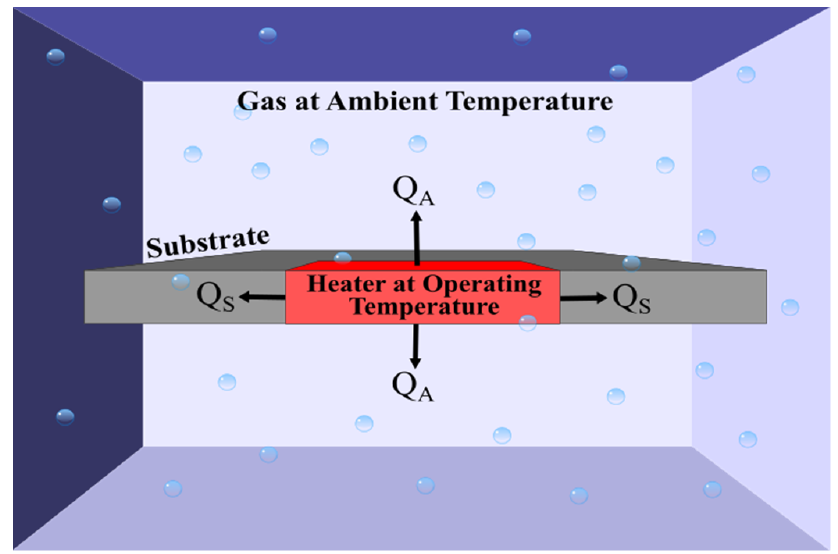
Figure 4. A basic illustration of the working principle behind a thermal conductivity device with the addition of a supporting structure.